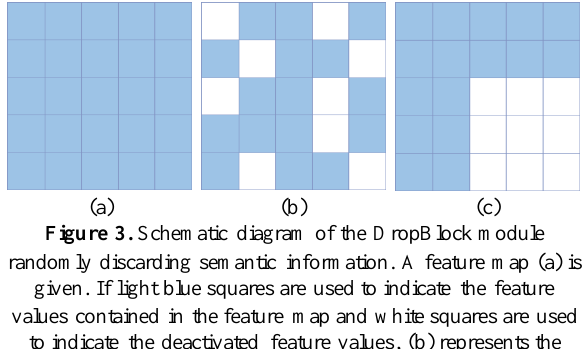
Figure 3. Schematic diagram of the DropBlock module randomly discarding semantic information. A feature map (a) is given. If light blue squares are used to indicate the feature values contained in the feature map and white squares are used to indicate the deactivated feature values, (b) represents the feature map obtained using random deactivation and (c) represents the feature map obtained using semantic